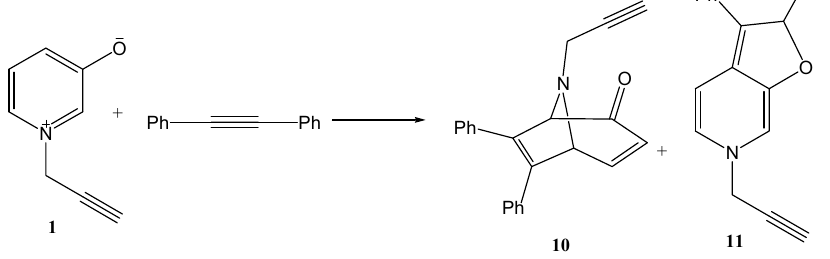
Scheme 6. Cycloaddition of diphenylacetylene with 1-(propergyl)-pyridinium-3-olate.